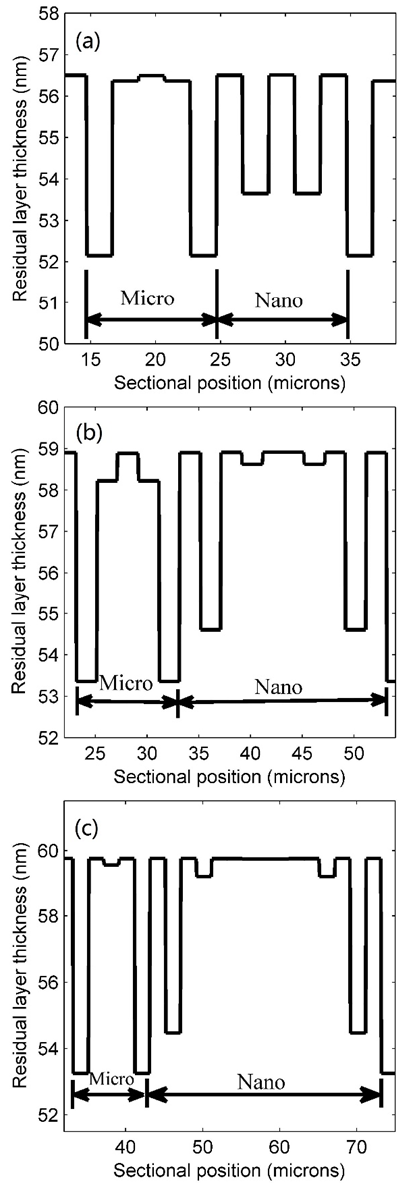
Figure 8. Residual layer thickness (RLT) profiles for micro/nano ratios of ( a ) 1:1; ( b ) 1:2; and ( c ) 1:3.